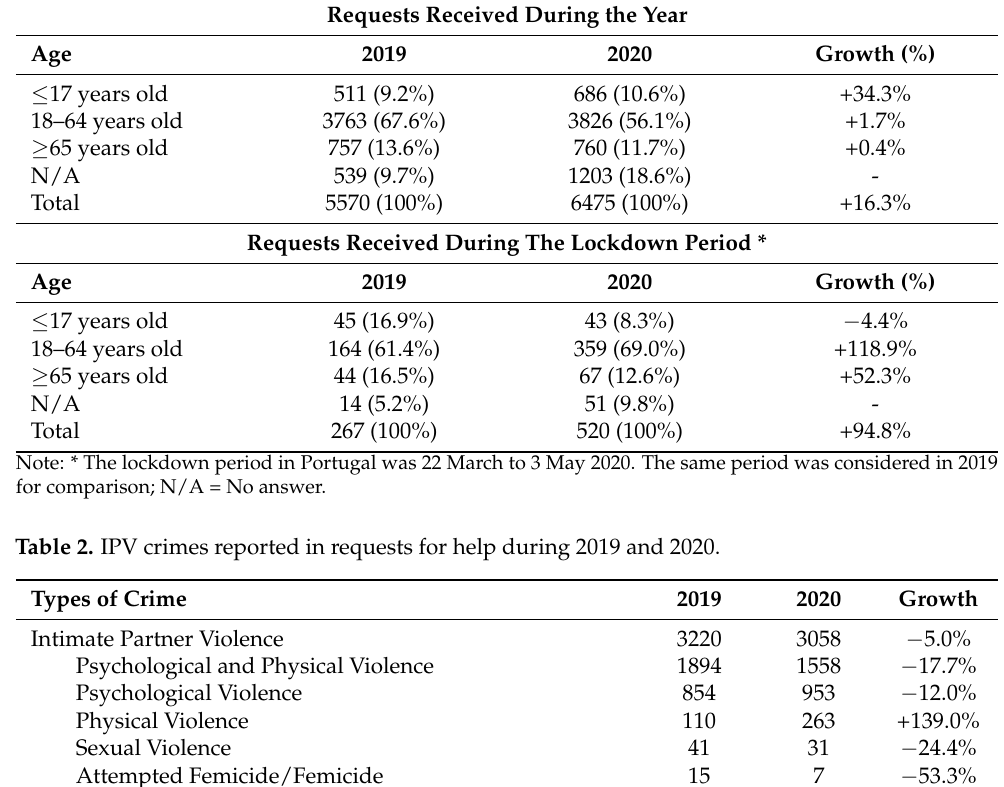
Table 1. Number of requests for help from female victims by age group in 2019 and 2020 and during the period of lockdown.